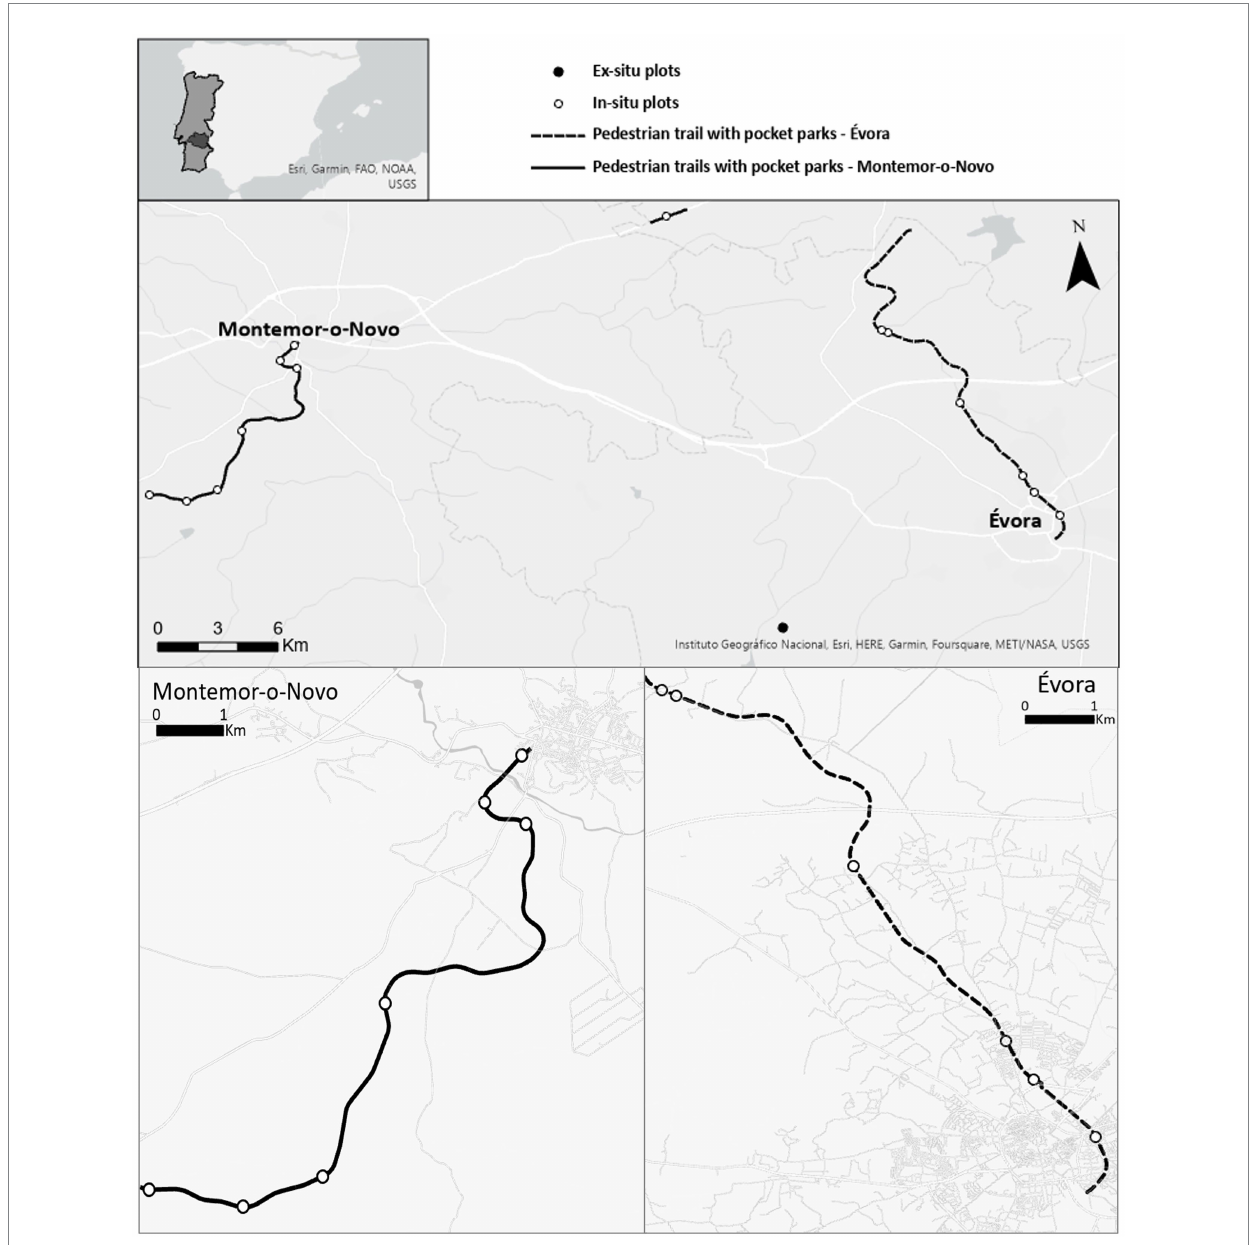
FIGURE 1 Ex-situ and in-situ plots installed on the experimental field of the University of Évora and pocket parks distributed throughout pedestrian trails of Évora (six plots) and Montemor-o-Novo (eight plots),